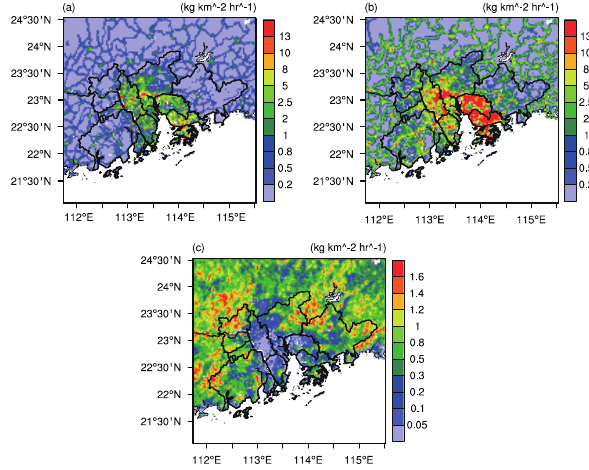
Fig. 2. Spatial distributions of anthropogenic and biogenic emission flux in the Pearl River delta (PRD) region: (a) nitric oxide; (b) total anthropogenic VOCs; (c) total biogenic